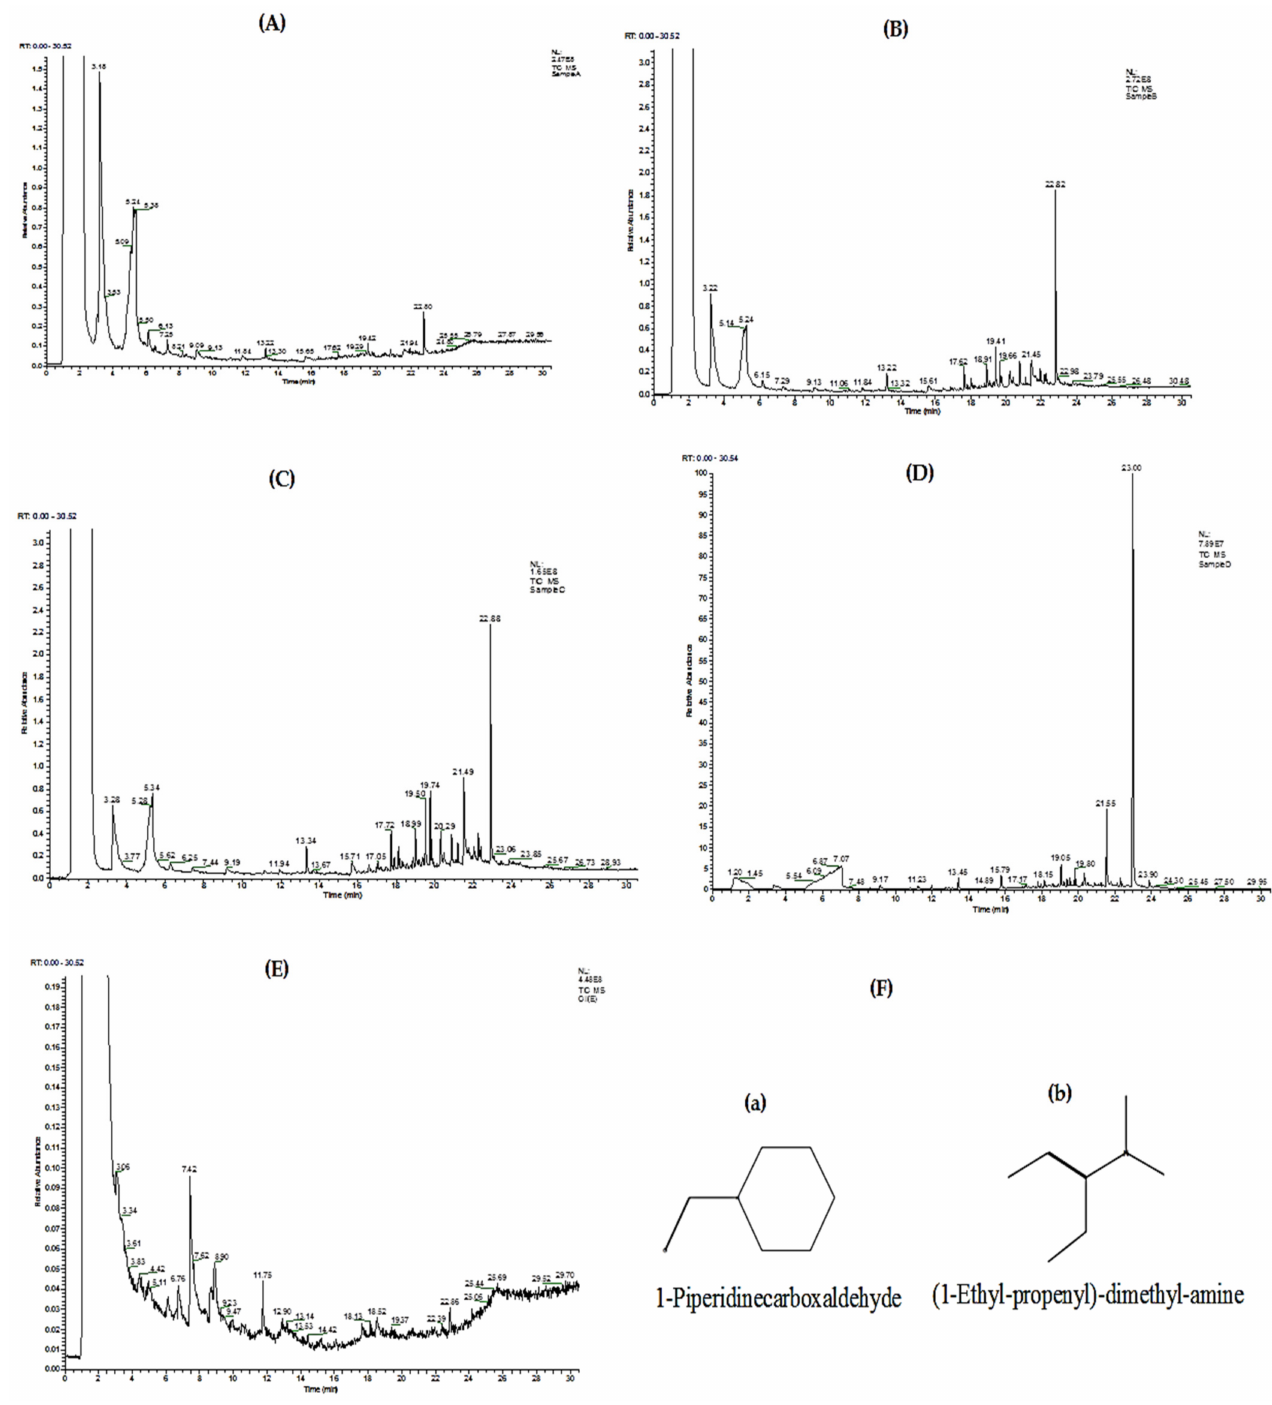
Figure 5. GC-MS chromatogram of A. articulata purified fractions ( A – D ) , oil fraction ( E ), and major phytochemical compounds ( a , b ) identified in the oil fraction ( F